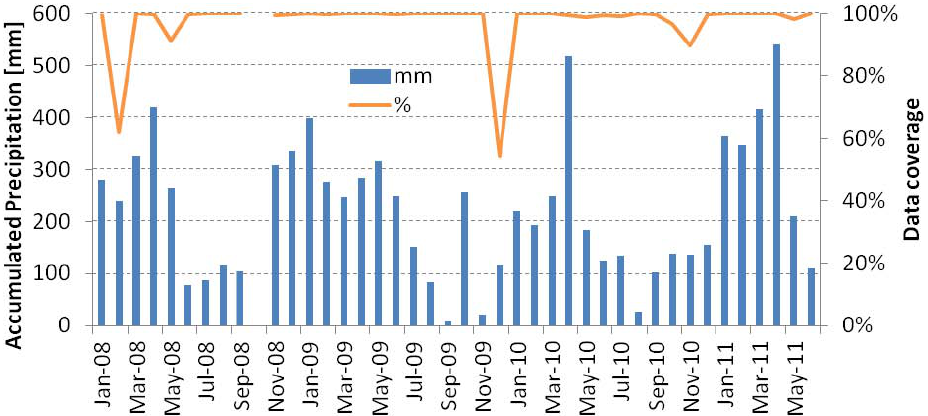
Fig. 2. Monthly accumulated precipitation measured at INPA’s K34 tower from January 2008 to June 2011. The line represents the percent data coverage for each month.